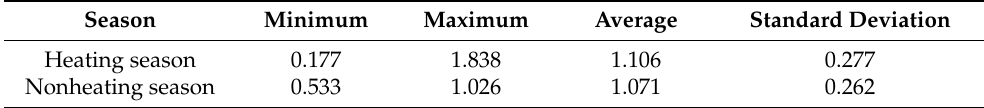
Table 2. Statistics of ρ (EBC370)/ ρ (EBC880)